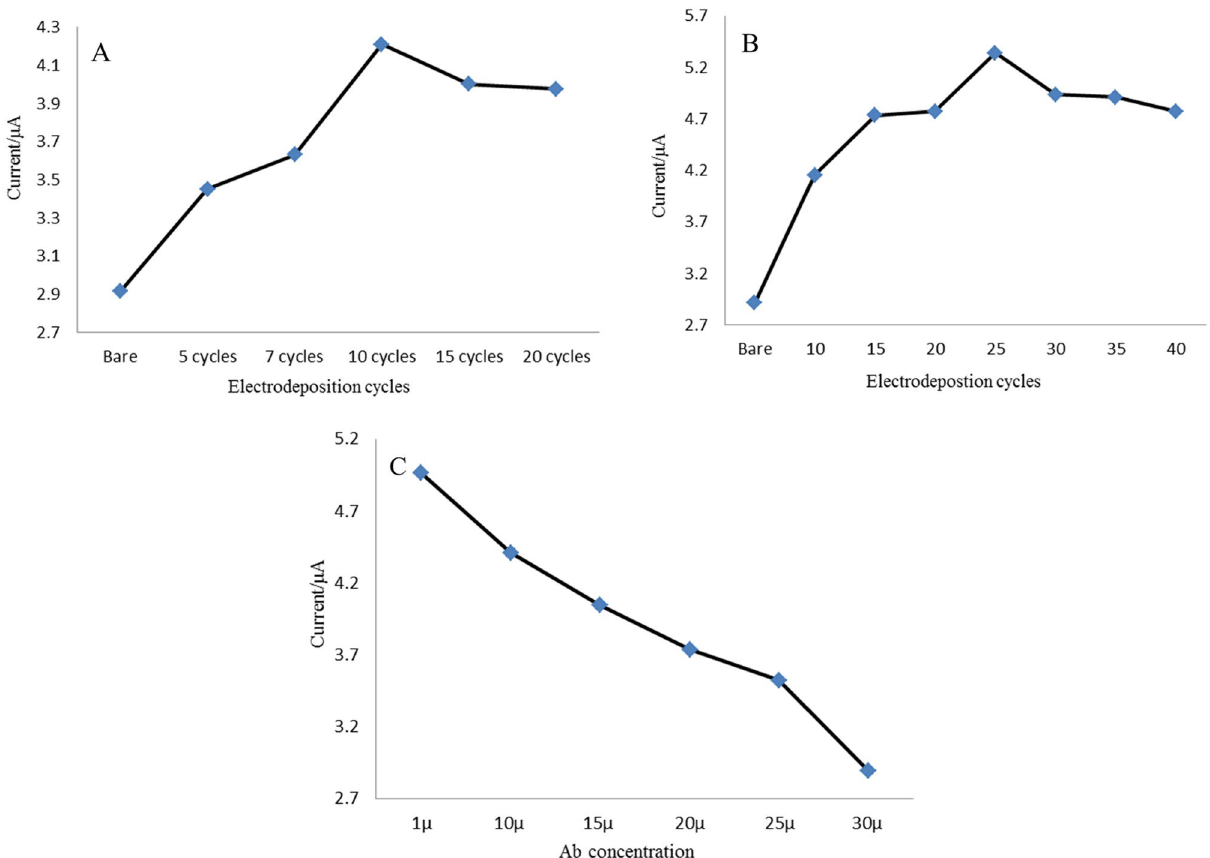
Figure 3. Optimization of the experimental conditions. Effect of ( A ) NiFe-LDH/rGO electrodeposition cycles number; ( B ) the AuNPs electrodeposition cycles number and ( C ) different anti-ROR1 concentration on the current response.